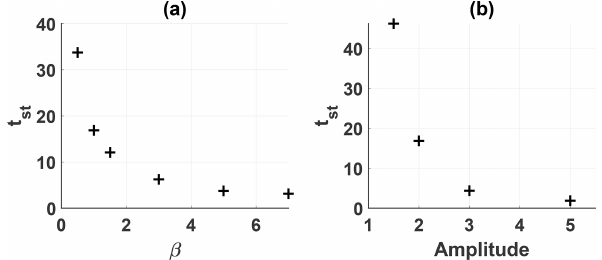
Figure 13. Normalized steepening time as a function of the plasma β (a) and the amplitude (b)